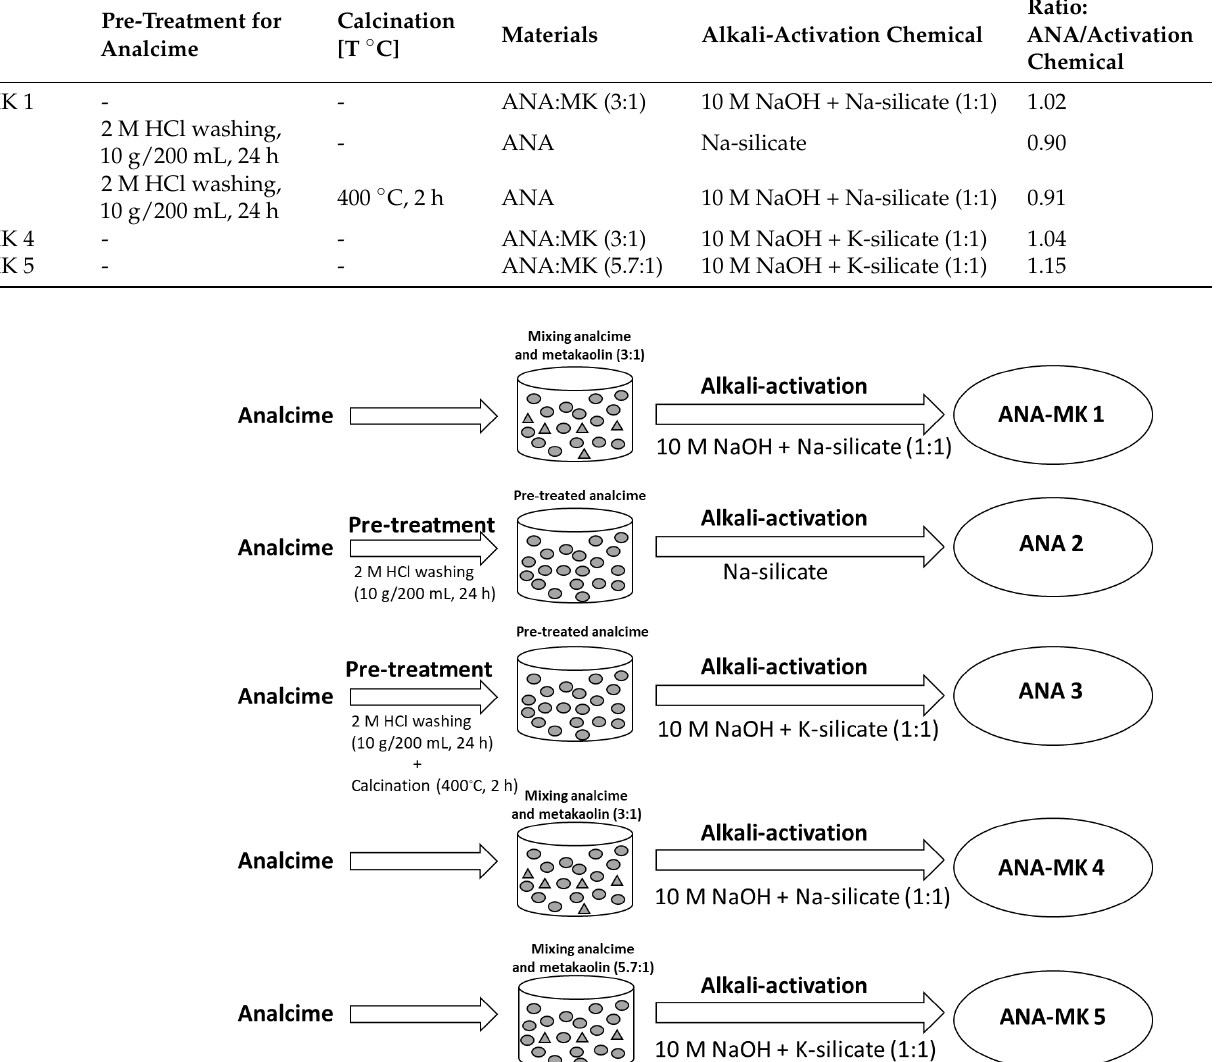
Figure 2. Schematic diagram of the alkali-activated analcime sorbents.